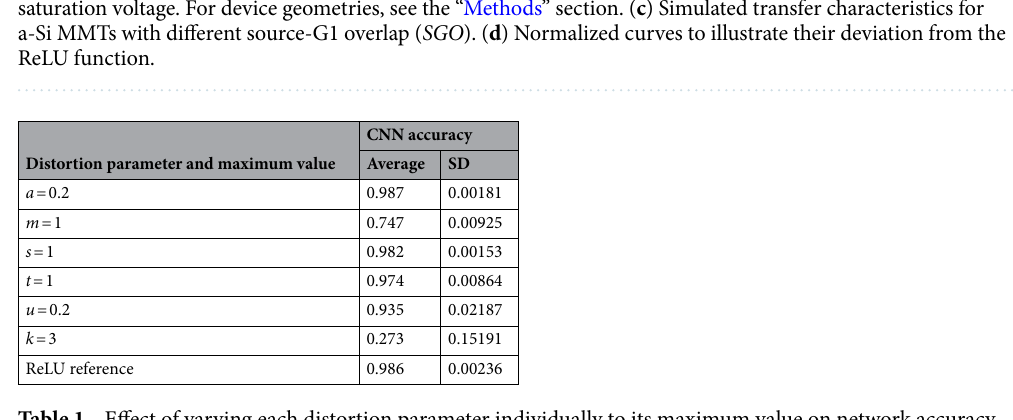
Table 1. Effect of varying each distortion parameter individually to its maximum value on network accuracy.